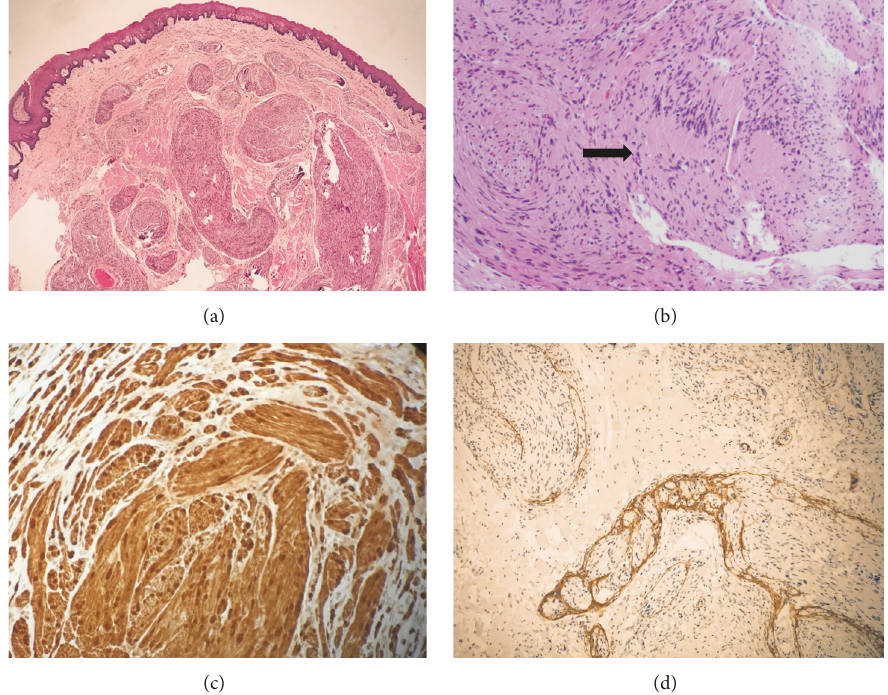
Figure 2: Histology of plexiform schwannoma. (a) Tumor cells forming interlacing fascicles and nodules (plexiform growth) (H&E, X20). (b) Cellular area with Verocay bodies (arrow), formed by palisading of nuclei and separated by cell processes of Schwann cells (H&E, X100). (c) Tumor cells are strongly and diffusely positive for S-100 (X100). (d) EMA-positive perineural fibroblasts surrounding nodules (X40).